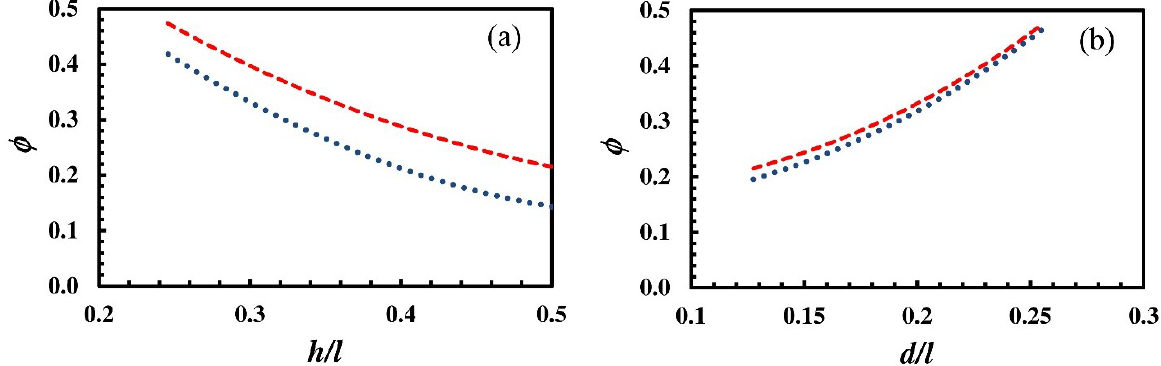
Figure 5. Relative density ϕ as a function of the ratios t / l ( a ) and d / l ( b ). The ratio h / l is kept constant at 0.5. Dotted (• • •) and dashed ( ‒ ‒ ‒ ) lines refer to the cases of ligaments with square and circular cross-sections, respectively.